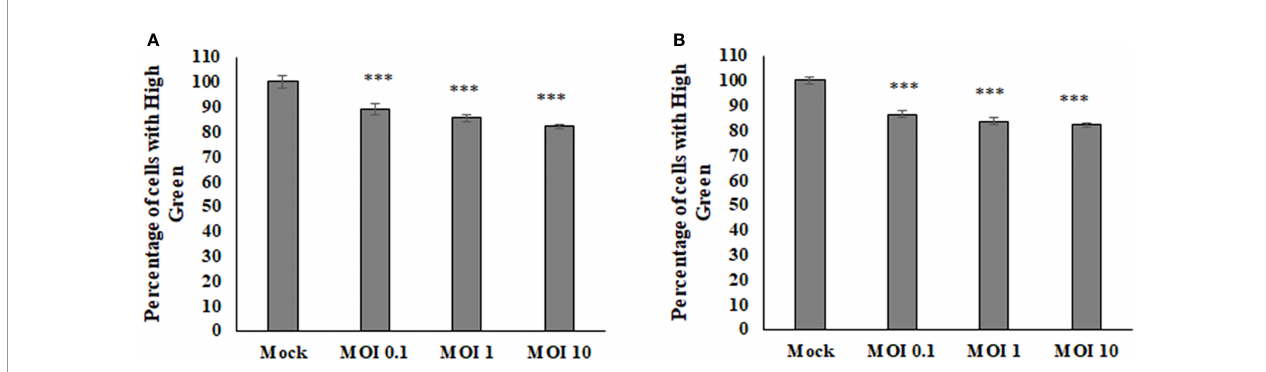
FIGURE 1 | The average amount of fl uorescence being picked up from the mitoView mitotracker decreases with increasing MOI in BHK cells (A) , HEK cells (B) .Statistical analysis was performed via a one way ANOVA and a tukey comparison test, where P < 0.001 is indicated by